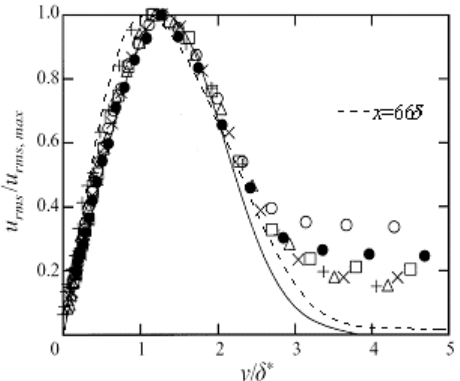
Fig. 5 Comparison to the incompressible data